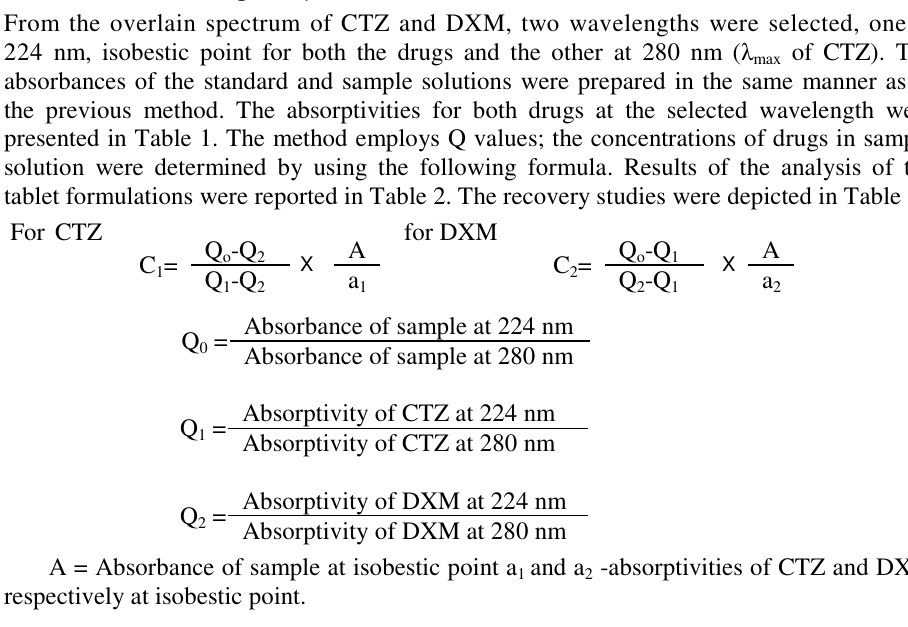
Table 1. Absorptivity values for cetrizine and